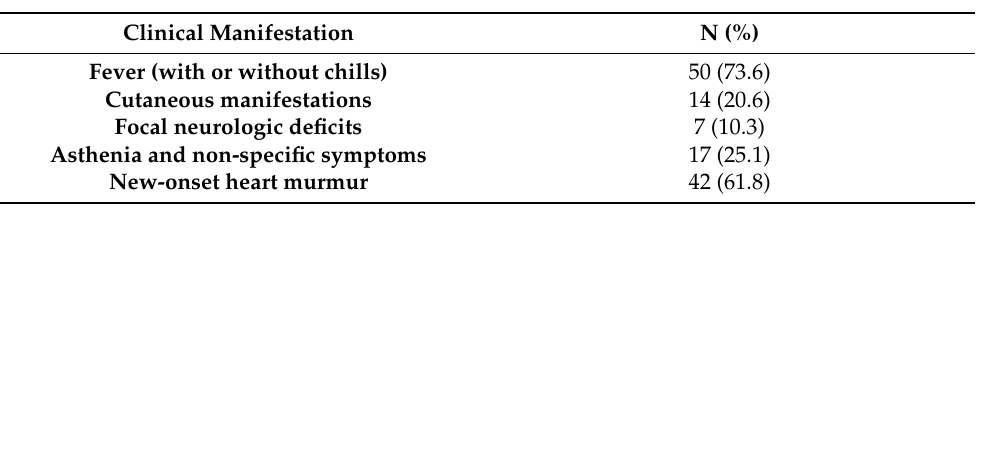
Table 2. Clinical manifestations in the cohort of 68 patients with infective